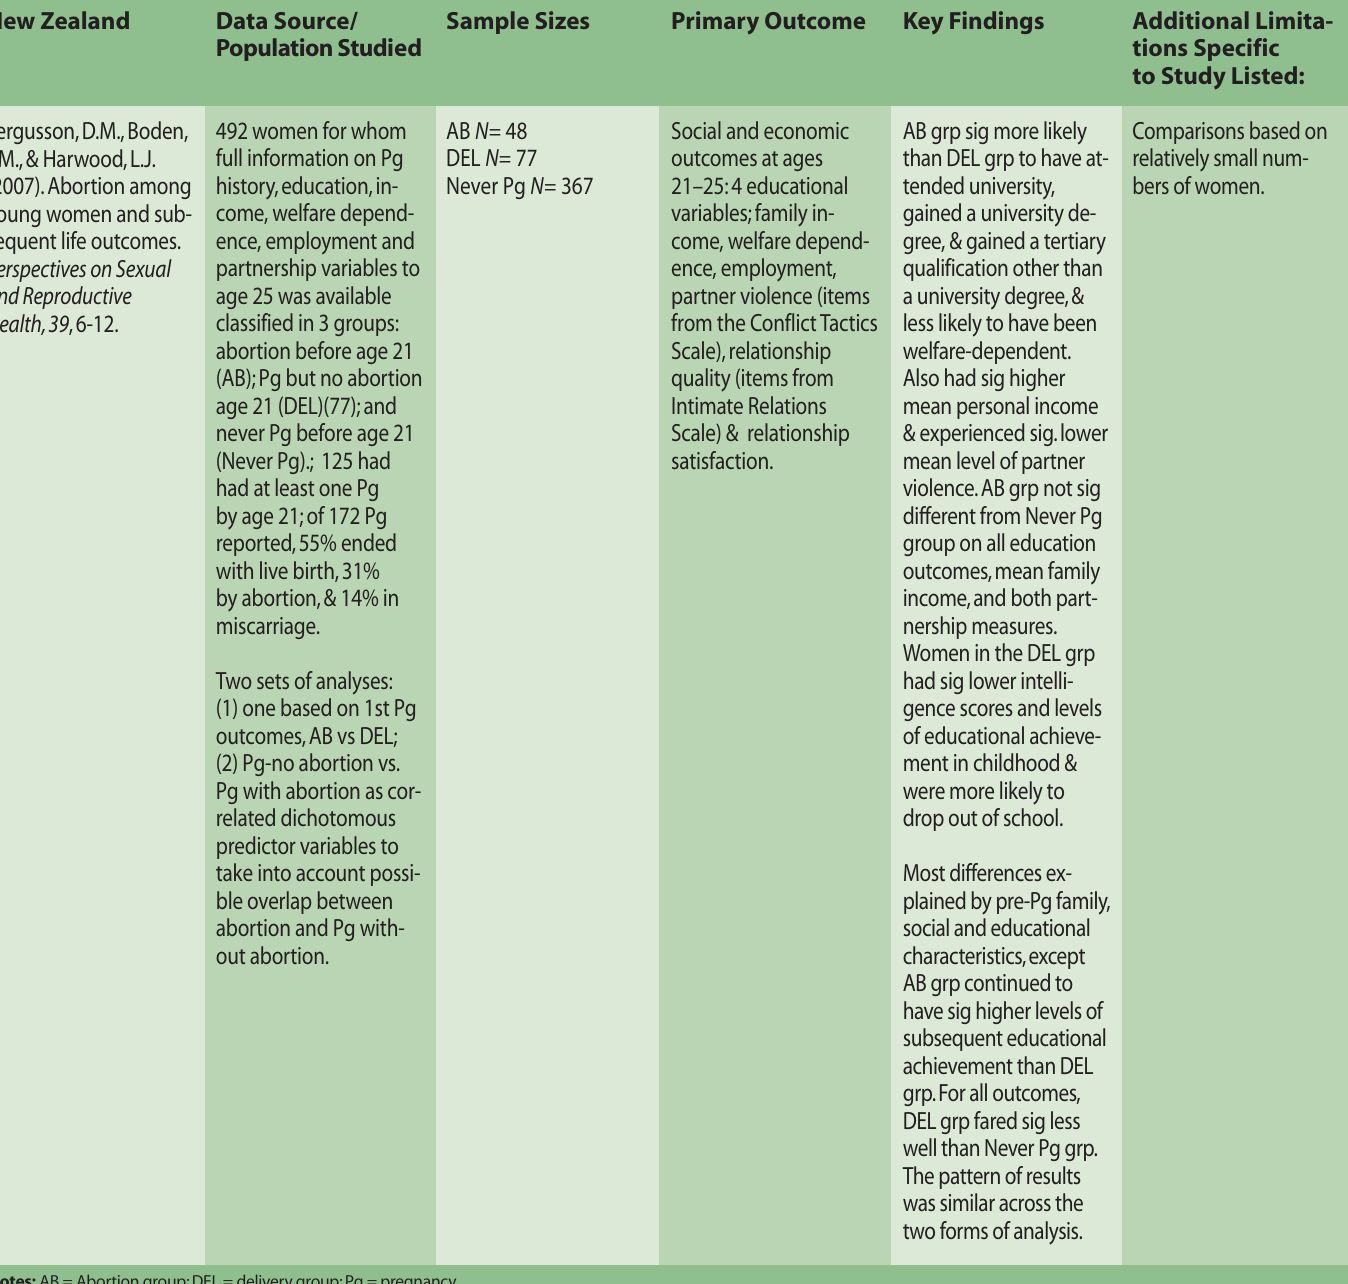
Table 1B: Secondary Analyses of Survey Data–Abortion vs.Comparison Groups INTERNATIONAL STUDIES–NEW ZEALAND